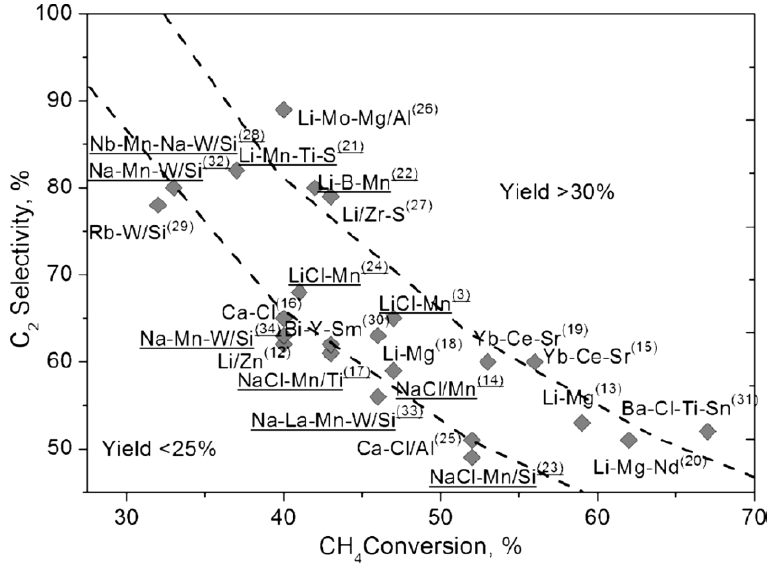
Figure 3. Various OCM catalysts with C 2 yields ( ≥ 25%). Reproduced with permission from [29]. Copyright 2011 Wiley-VCH.